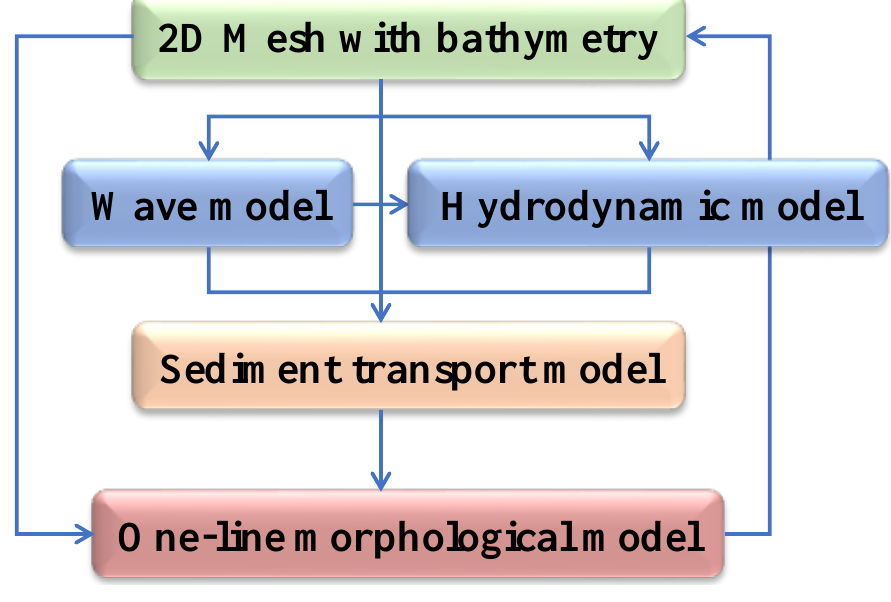
Figure 21. The concept of the MIKE21FM Shoreline model [36].